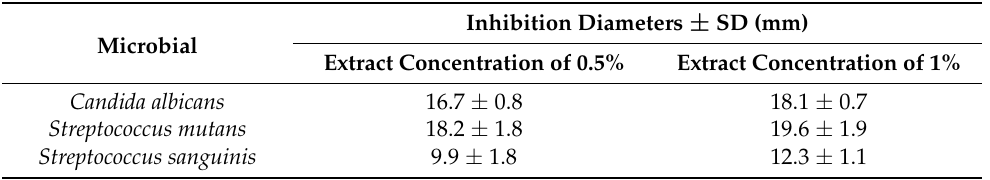
Table 1. Growth inhibition diameters of Candida albicans , Streptococcus mutans , and Streptococcus sanguinis by Piper betle var. nigra extract.